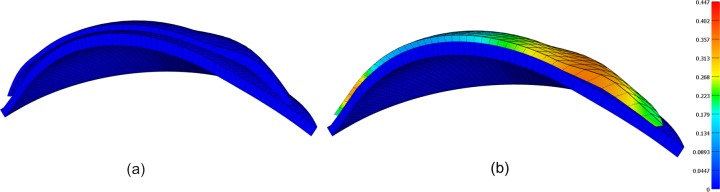
Contact lens finite element model, (a) before fitting, (b) after fitting where the maximum effective Lagrange strain at the final step of this simulation was 0.0768.